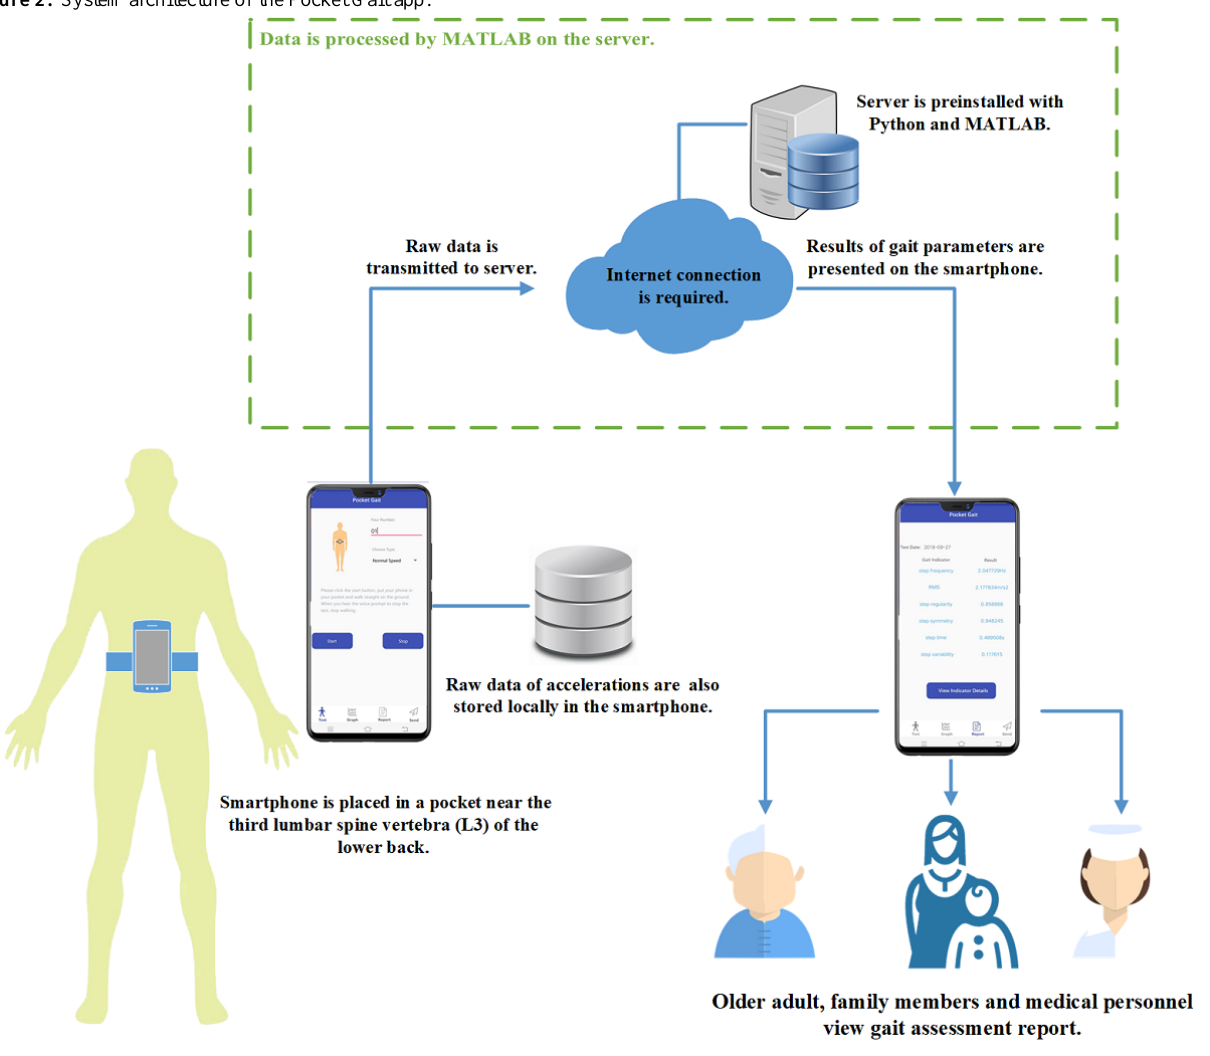
Figure 2. System architecture of the Pocket Gait